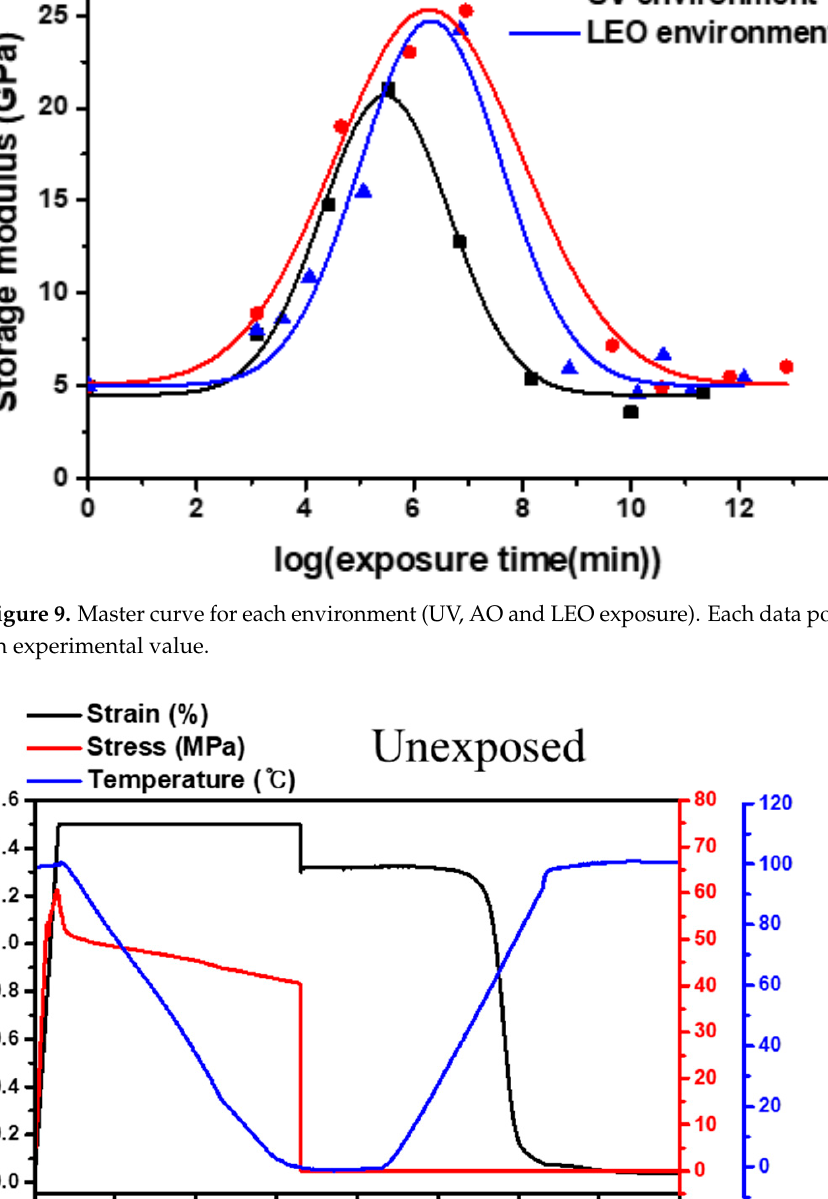
Figure 9. Master curve for each environment (UV, AO and LEO exposure). Each data point repre- sents an experimental value.